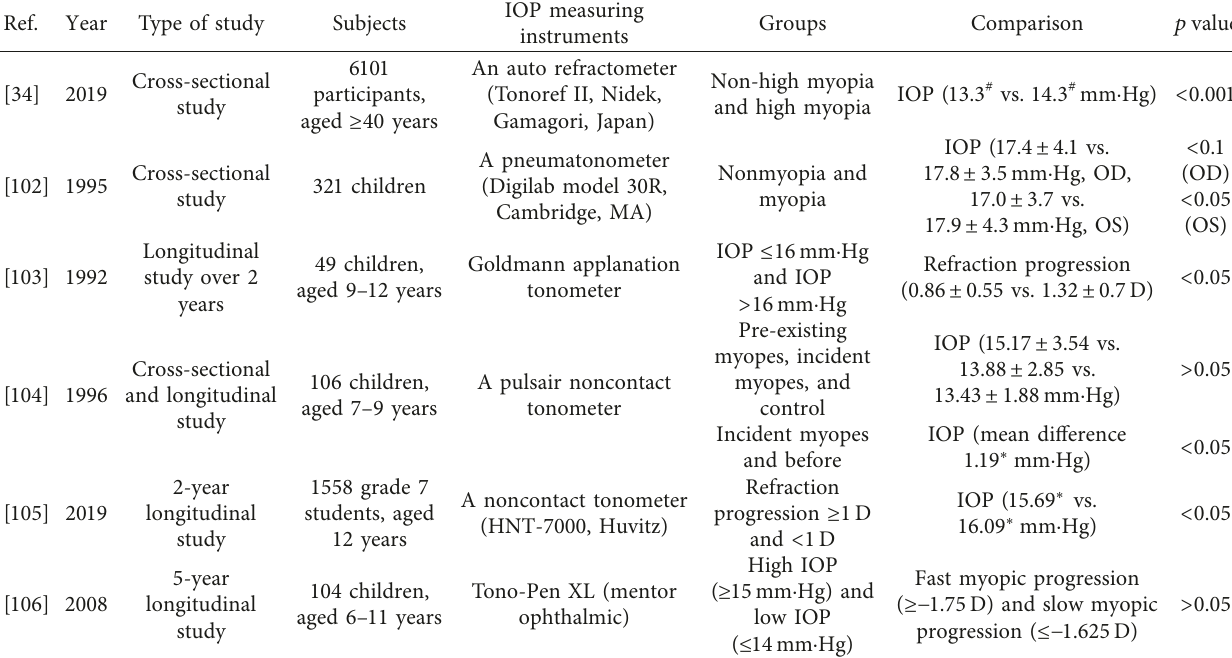
Table 2: Relationships between IOP levels and refractive errors in cross-sectional and longitudinal studies.